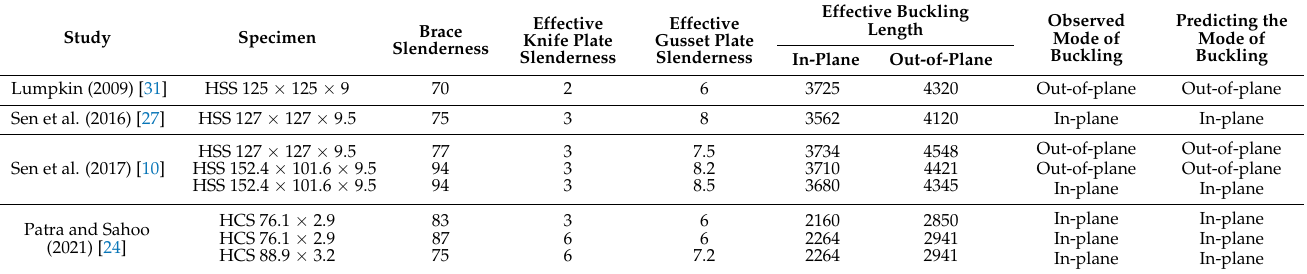
slenderness ratio, and λ is the normalized brace global slenderness ratio. Table 2 shows the comparison of the predicted and observed mode of buckling from past experimental studies. It is observed that the recently developed limit state criterion reliably evaluates the mode of buckling and prevents premature failure of the braced frame system. Table 2. Comparison of the predicted and observed mode of buckling from past experimental